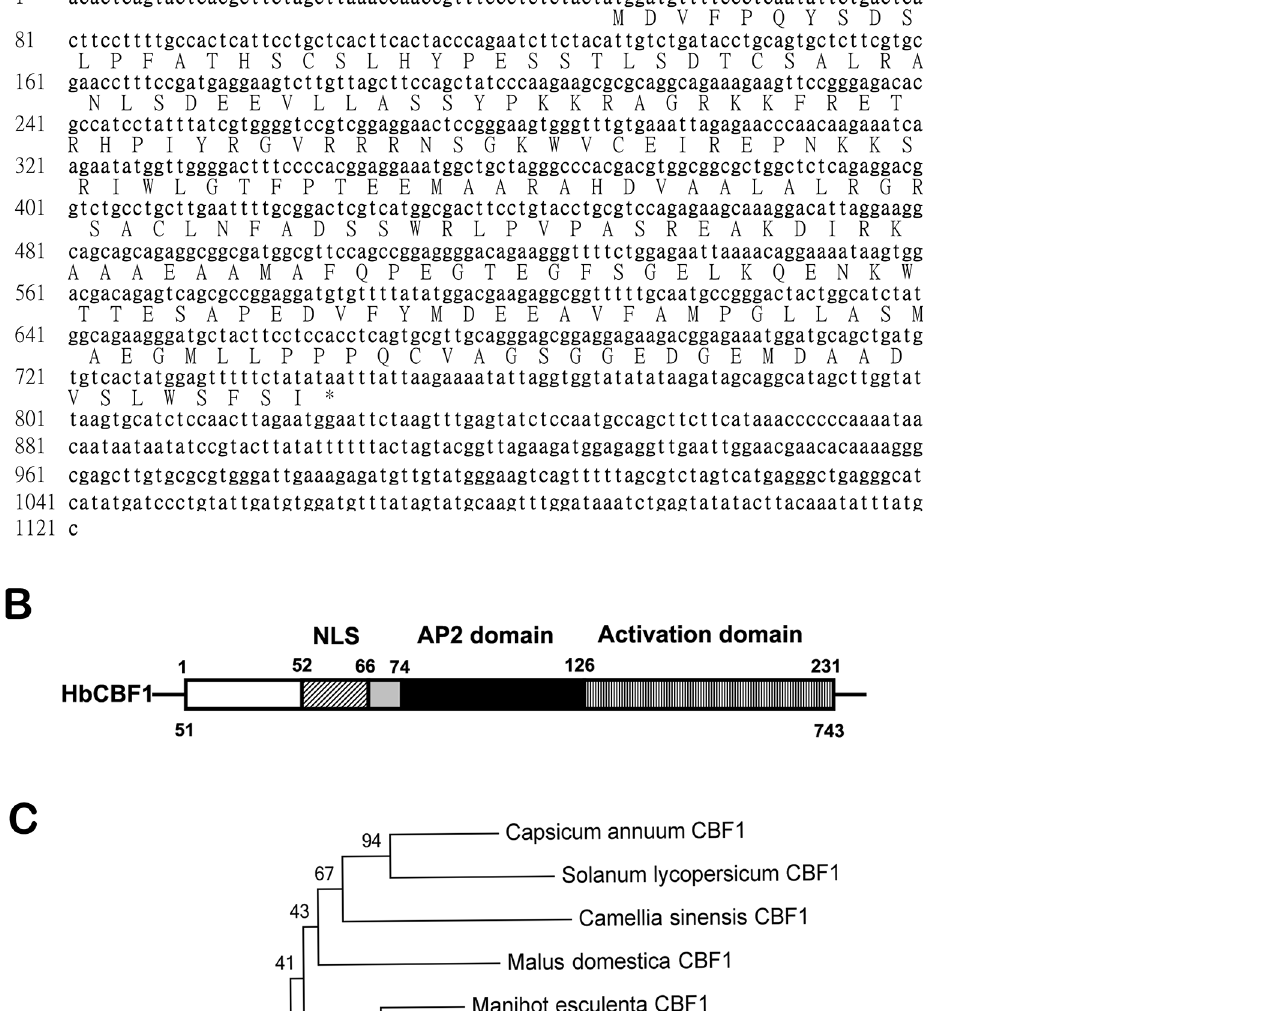
PLOS ONE | DOI:10.1371/journal.pone.0137634 September 11, 2015 5 /